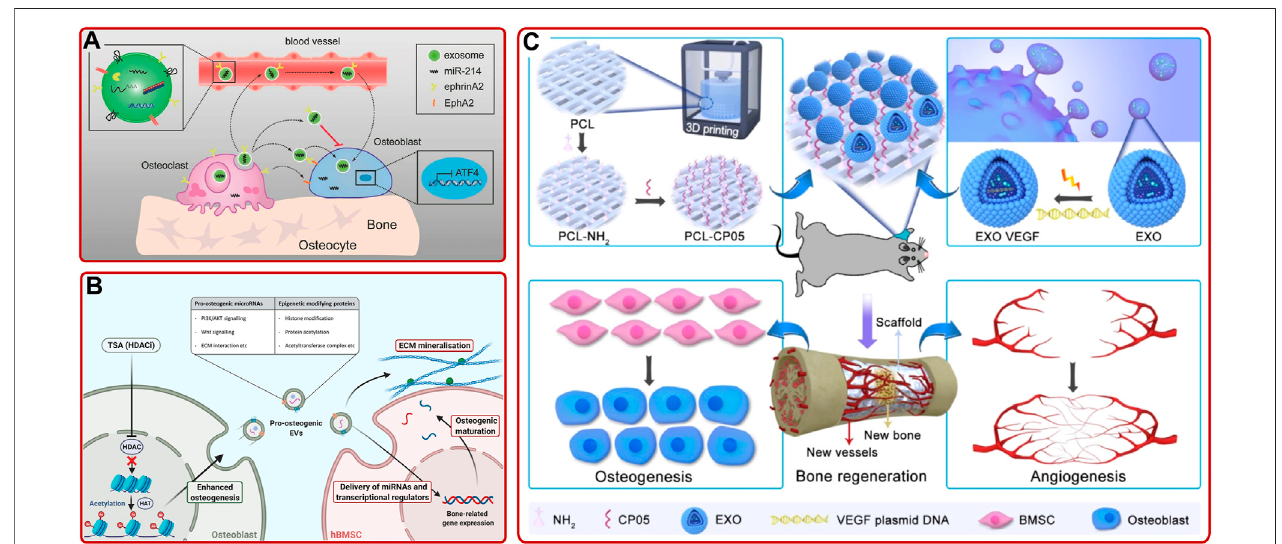
FIGURE 5 | (A) MiR-214-containing exosomes from osteoclasts inhibited osteoblast function via ephrinA2/EphA2 recognition and can also be secreted into the blood as a biomarker for bone loss (Sun et al., 2016). (B) Schematic illustration of the mechanism that osteoblast-derived EVs pretreated with TSA enhanced the osteogenic differentiation of hBMSCs and osteoblast mineralization (Man et al., 2021). (C) 3D-printed porous PCL scaffold functionalized with VEGF@CPC-derived exosomes exhibited better osteogenic and angiogenic ability (Zha et al.,